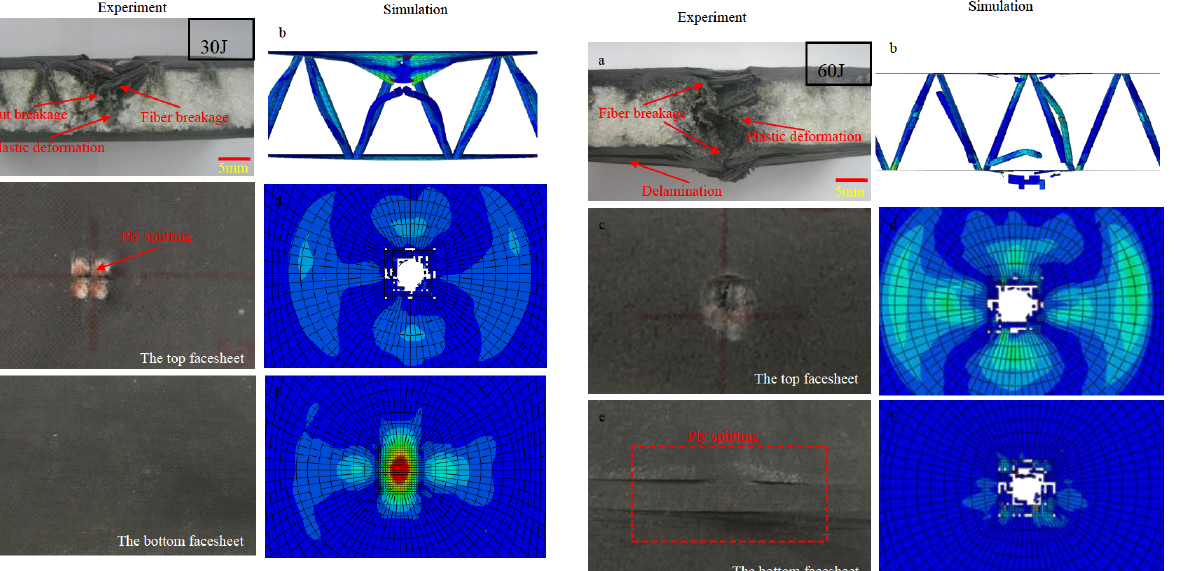
Figure 14: Impact damage of experimental and FEM simulation of foam sandwich composite stitched by 1mm diament strut at the impact energy of 30J.